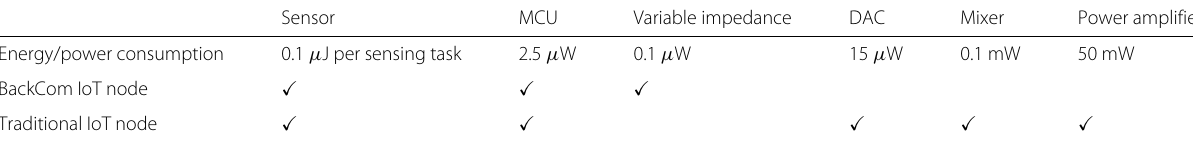
Table 2 Comparison of active components of BackCom and traditional IoT nodes